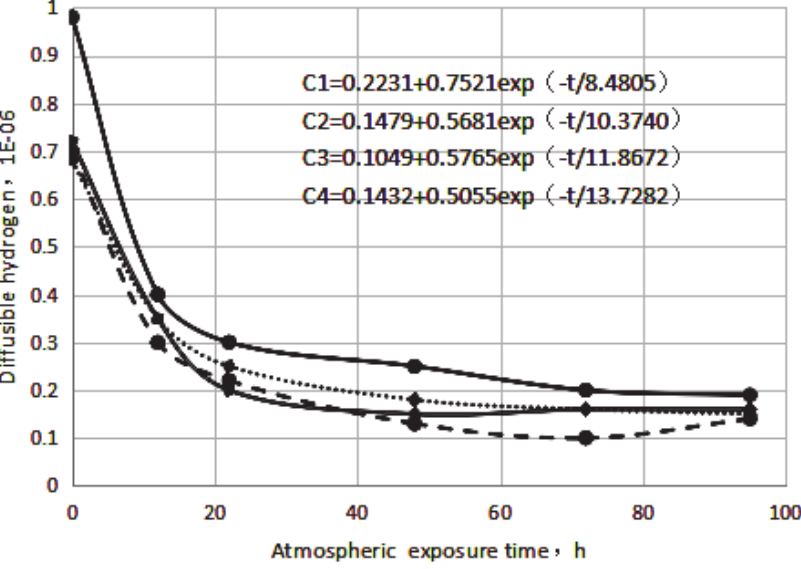
Figure 9: Effects of storage time after hydrogen charging on the concentration of diffusible hydrogen of experimental materials in different